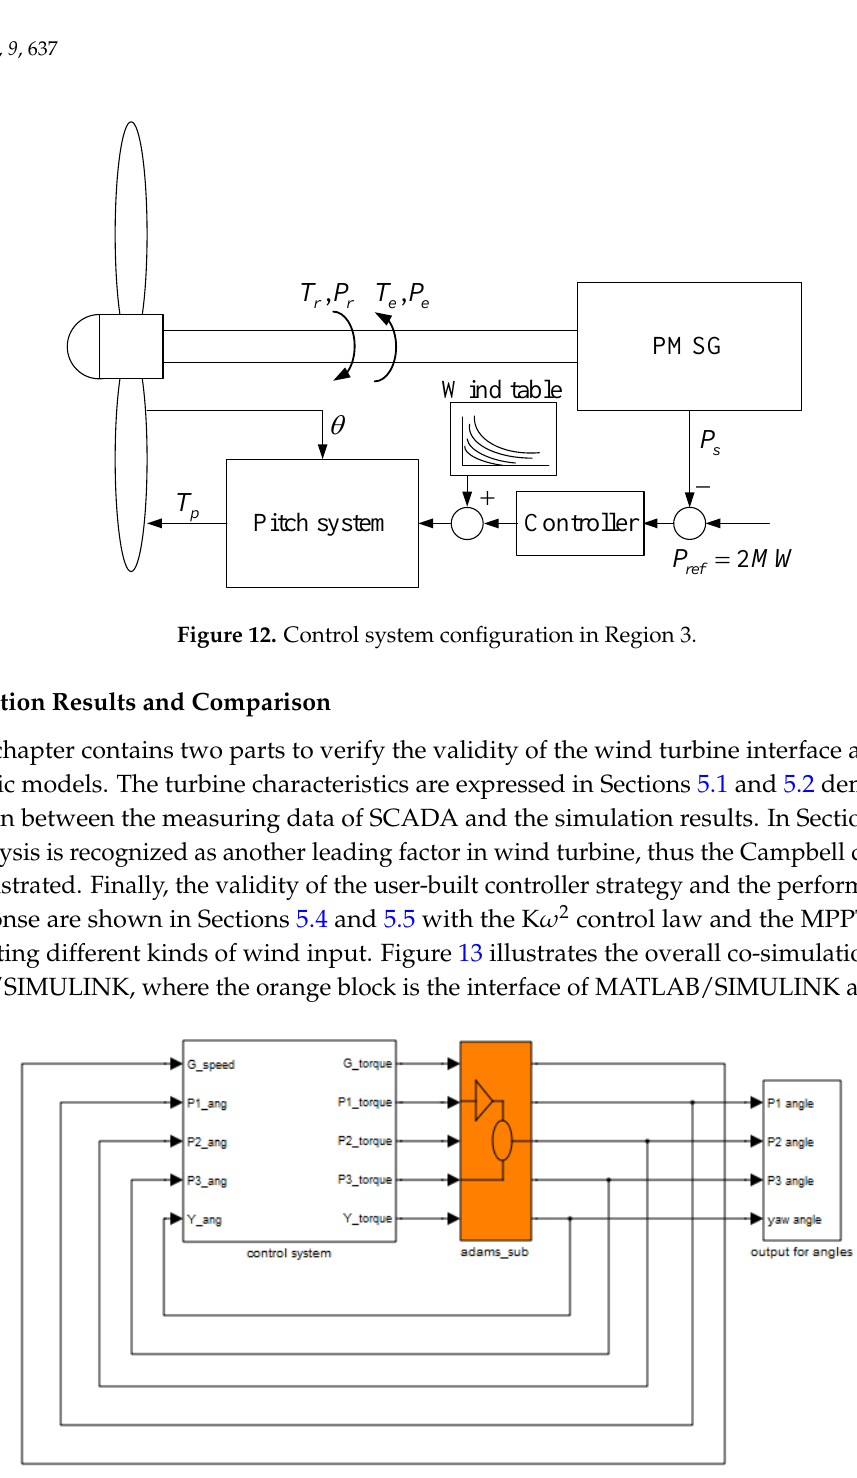
Figure 13. Overall co-simulation system in MATLAB/SIMULINK.